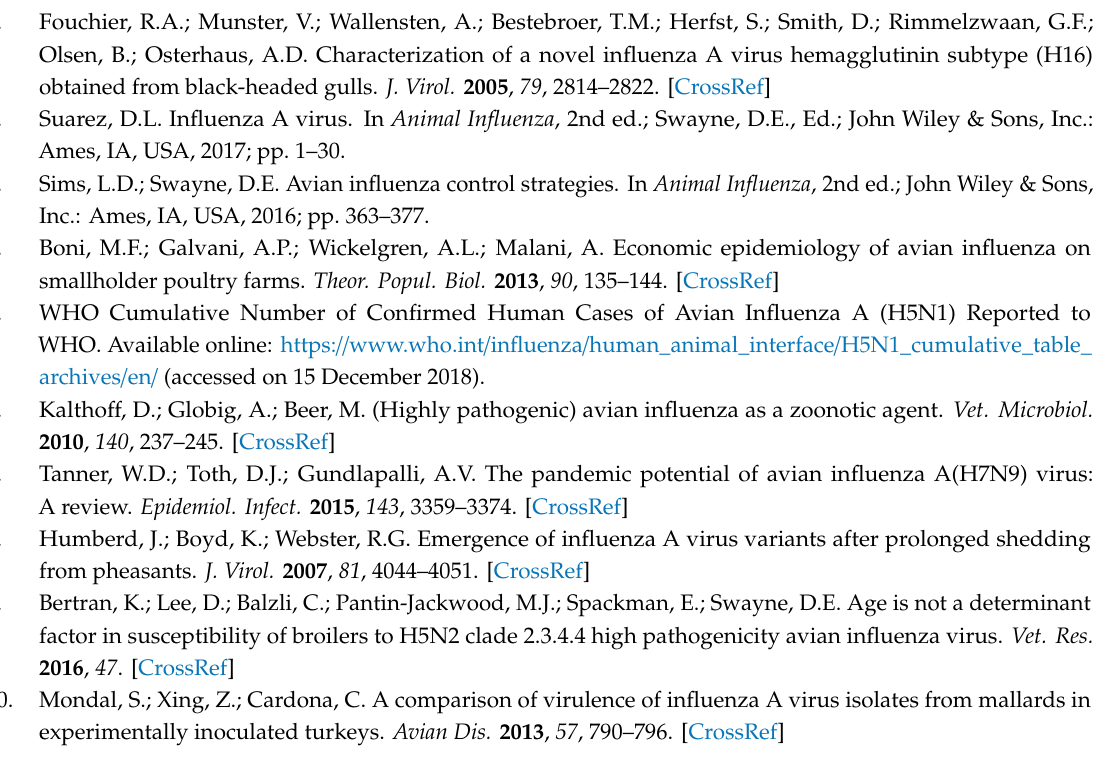
Figure S1. Mean shedding (log 10 EID 50 / mL) in respiratory and cloacal swabs of a) HPAIV and b) LPAIV for di ff erent subtypes. Table S1. Summary of the systematic review protocol, Table S2. Complete overview of search terms used in PubMed and Ovid, Table S3. References of all included